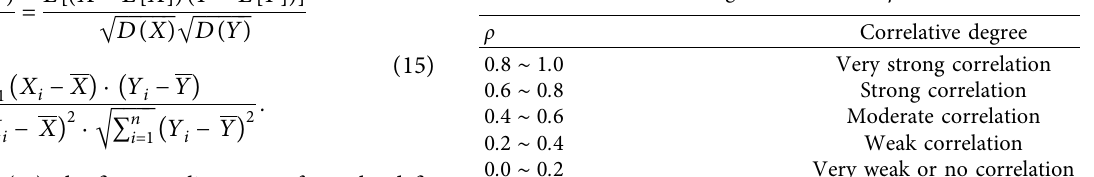
Table 1: Correlative degree for diferent ρ absolute